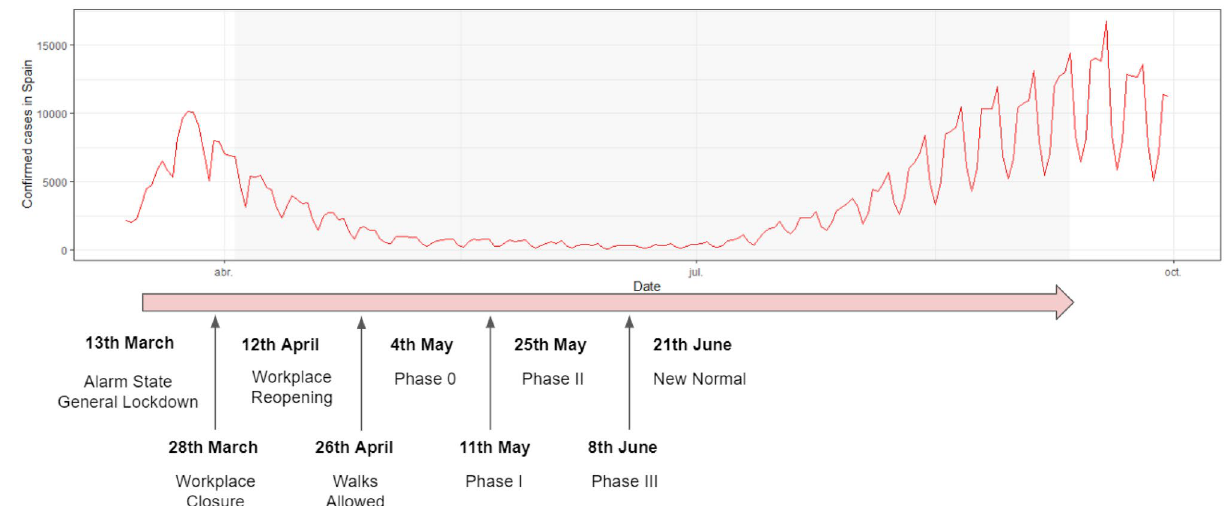
Figure 5. Confinement phases and daily number of confirmed COVID-19 cases in Spain between March and September of 2020. The shaded part of the graph corresponds to the time period of